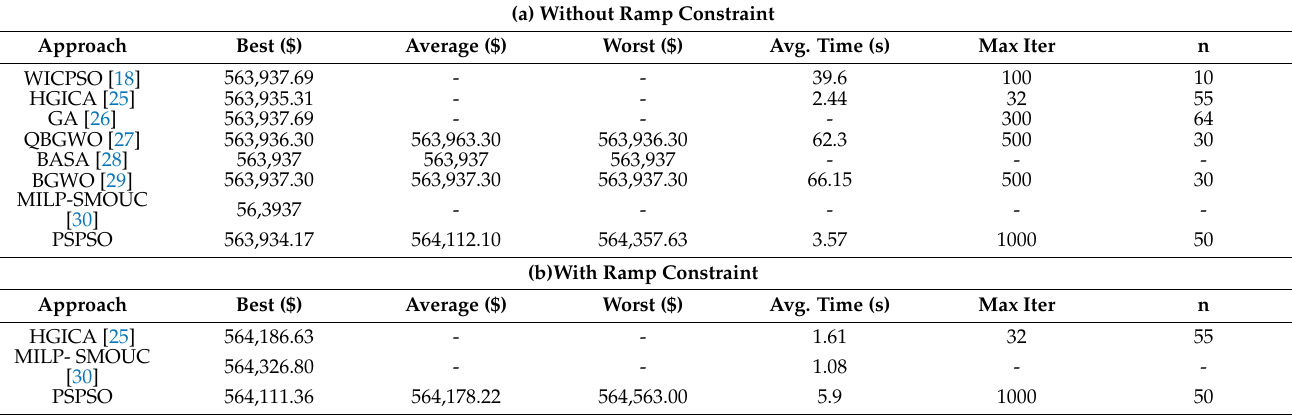
Table 12. Benchmark unit commitment (UC) problem. (a) Without Ramp Constraint